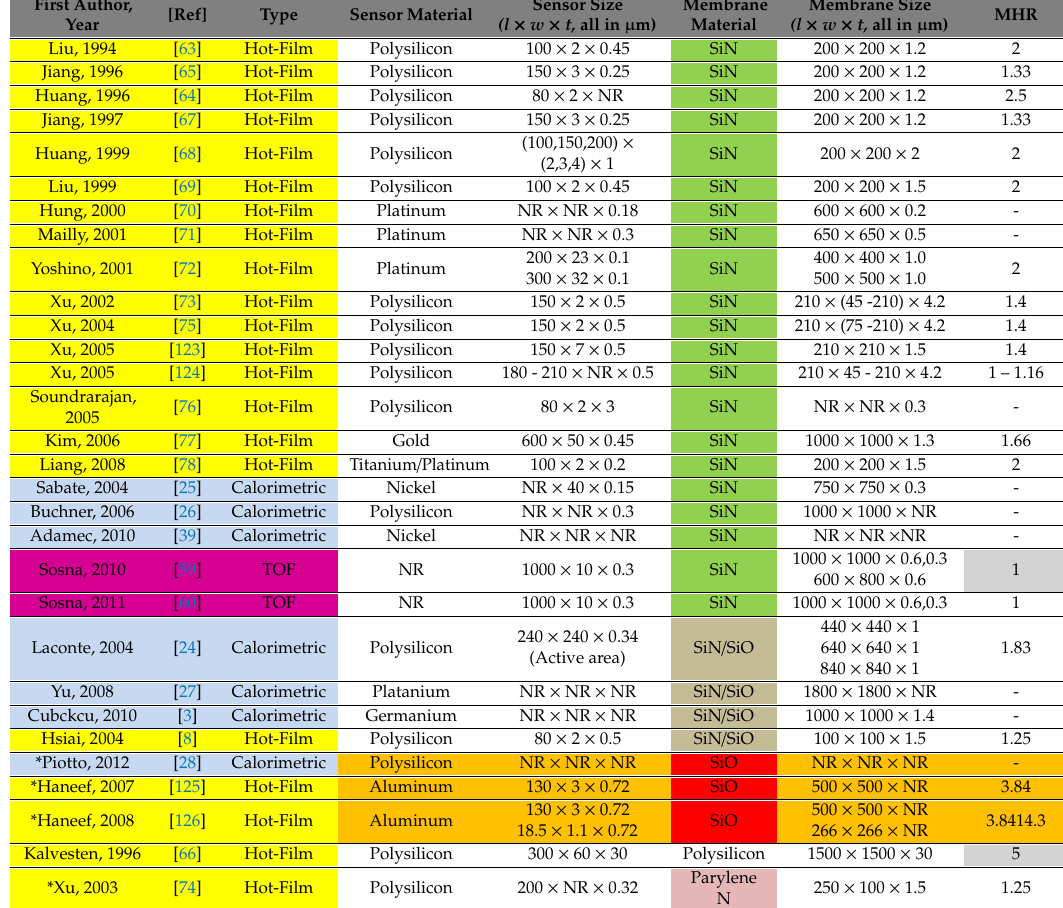
Table 3. MEMS Thermal Flow Sensors with Square